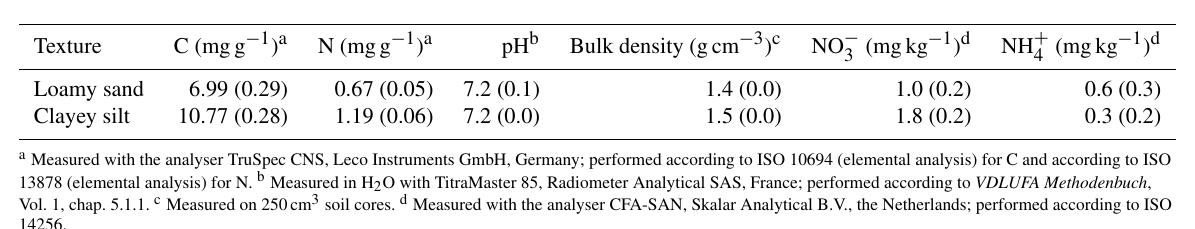
Table 2. Characteristics of both soils. Texture and mean values with standard deviations (in parentheses) for carbon (C, n = 9), nitrogen (N, n = 9), pH ( n = 3), bulk density (BD, n = 3) and mineral N (NO − Texture C (mgg − 1 ) a N (mgg − 1 ) a pH b Bulk density (gcm − 3 ) c NO − Loamy sand Clayey silt